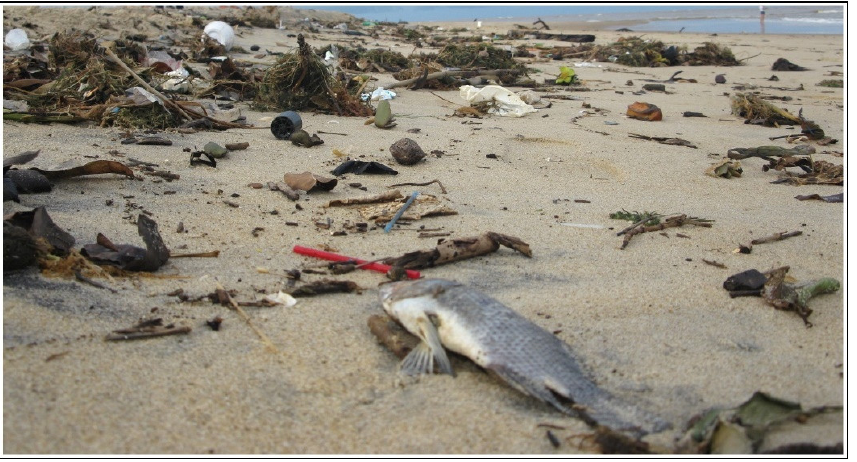
Figure 10. Dead fish among garbage, plastic, and urban debris remobilized by the waves in an area near the mouth (21°37′15.22″ S, 41° 0′47.62″ W, SW-NE view). Photo by: L. Lämmle, 2021.